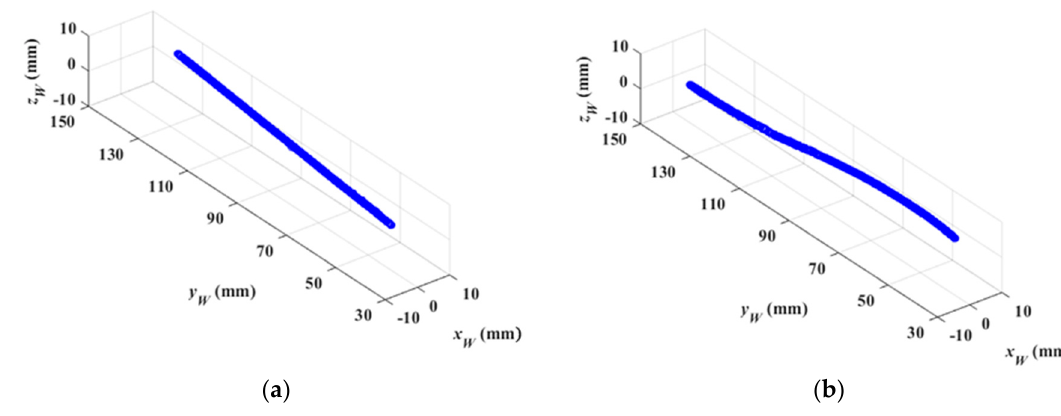
Figure 25. The 3D reconstruction of the groove path. ( a ) The straight line path; ( b ) The S-curve path.